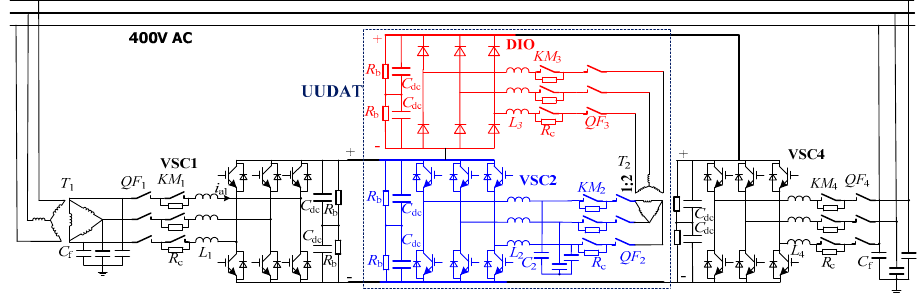
Figure 10. Schematic of the experimental set-up of UUDAT.